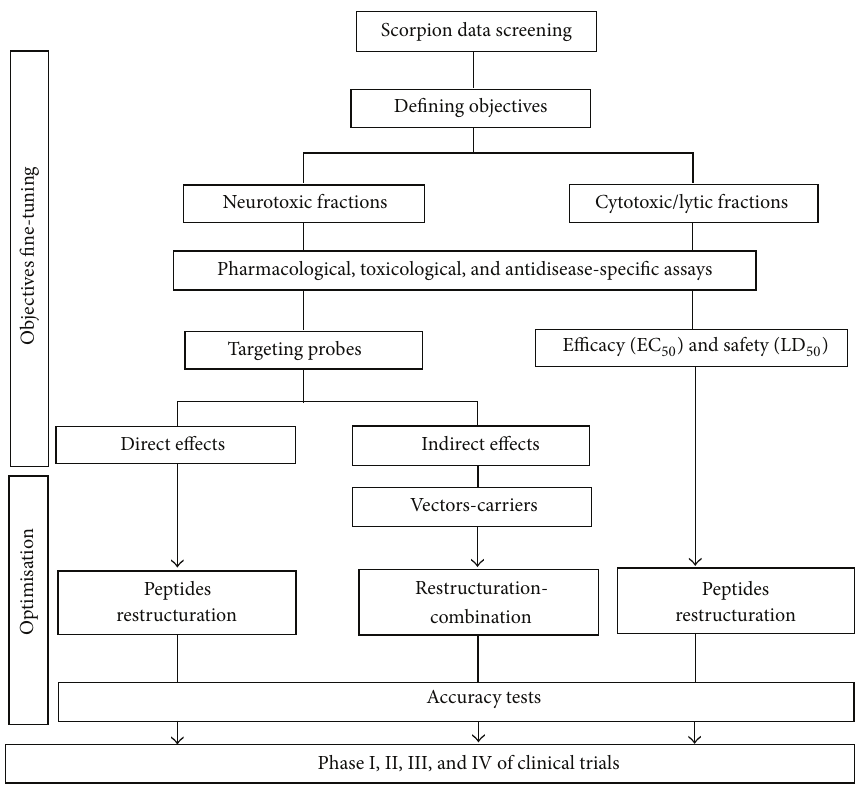
Figure 2: Schematic model representing the process in need to distillate scorpion derivatives with potential clinical